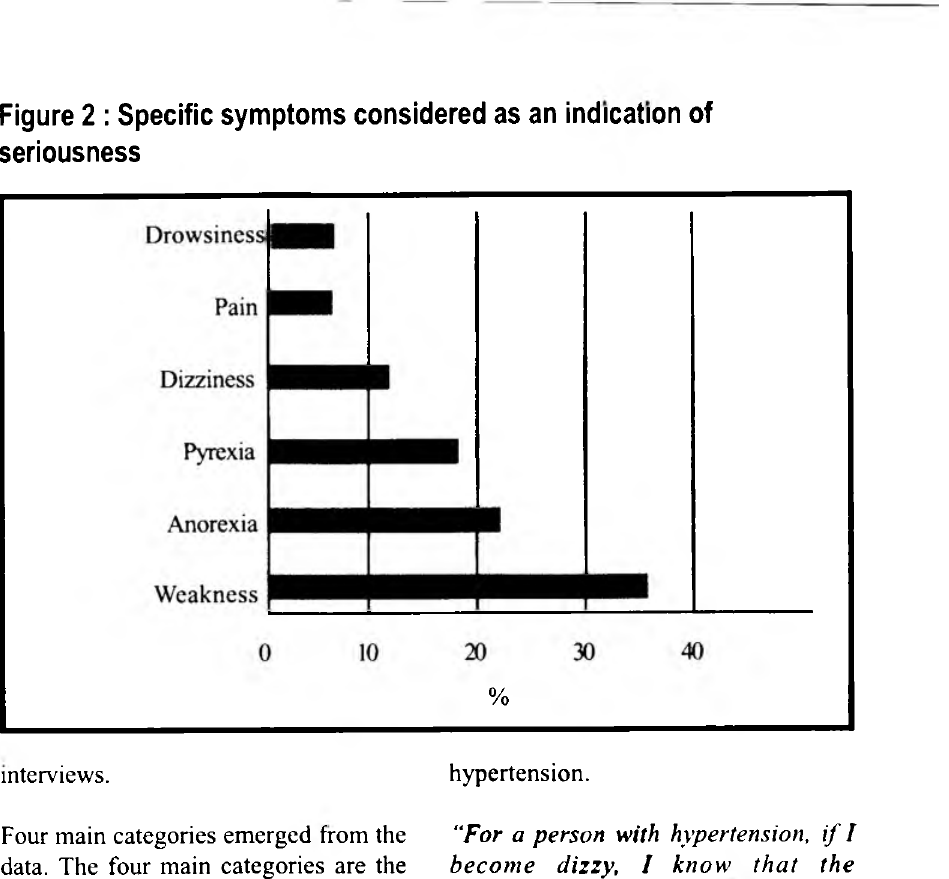
Figure 2 : Specific symptoms considered as an indication of